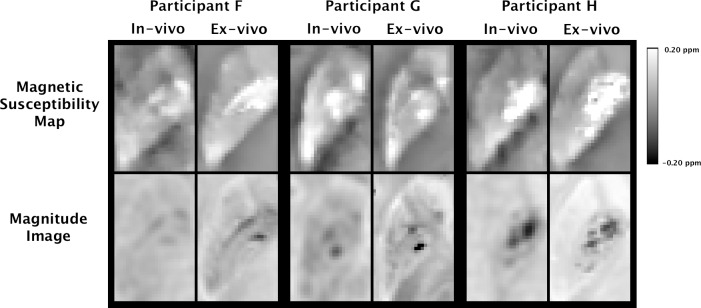
Correspondence of in-vivo and ex-vivo data within the same participants.In-vivo and ex-vivo magnetic susceptibility and gradient-echo magnitude maps for a section of the basal ganglia of three hemispheres from Dataset 2 imaged both in-vivo and ex-vivo.